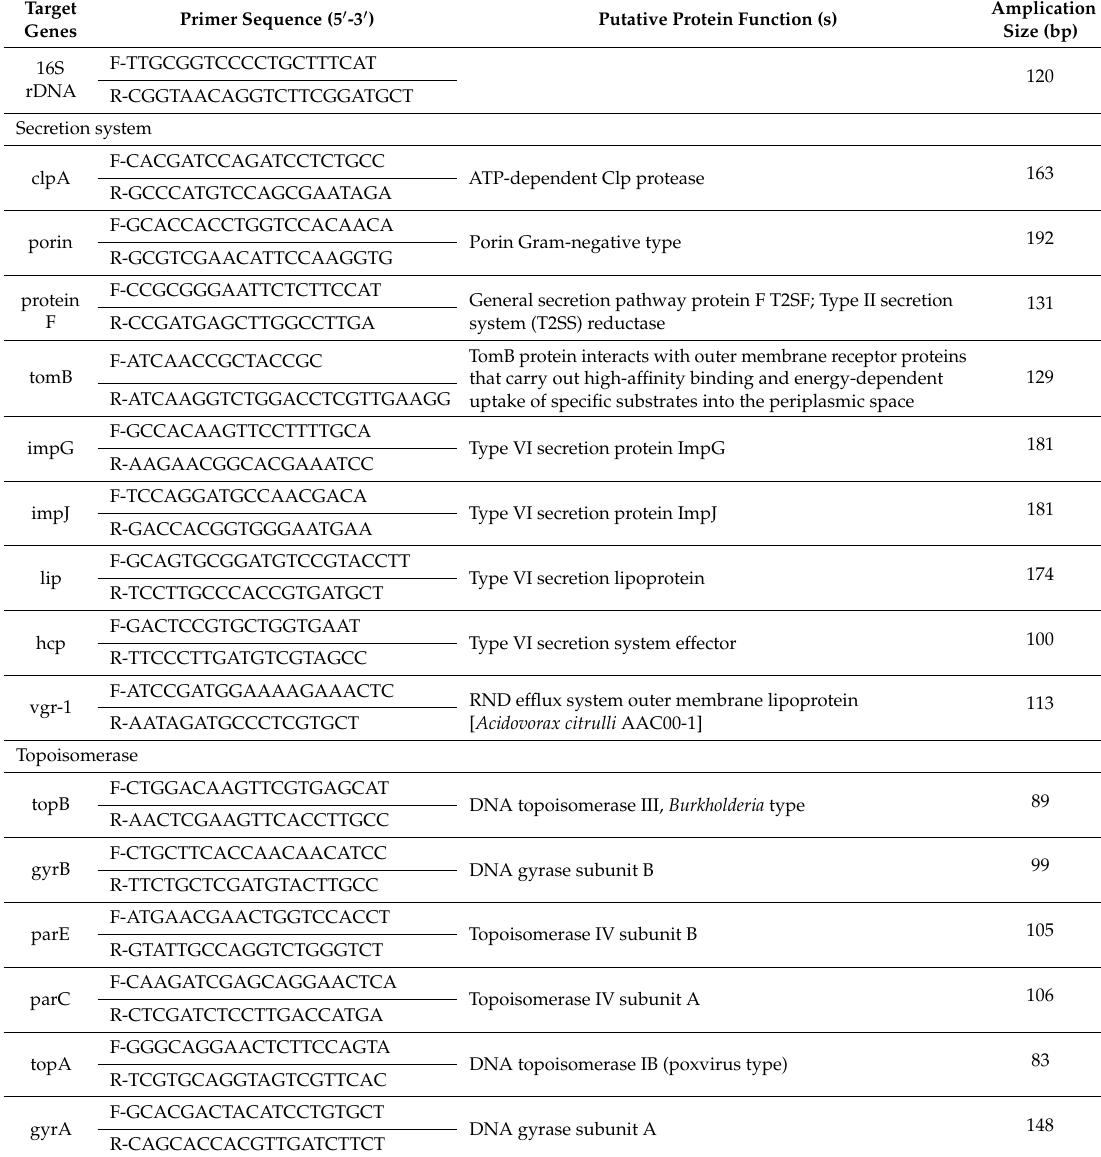
Table 1. Primers of target genes used for quantitative real-time PCR in this